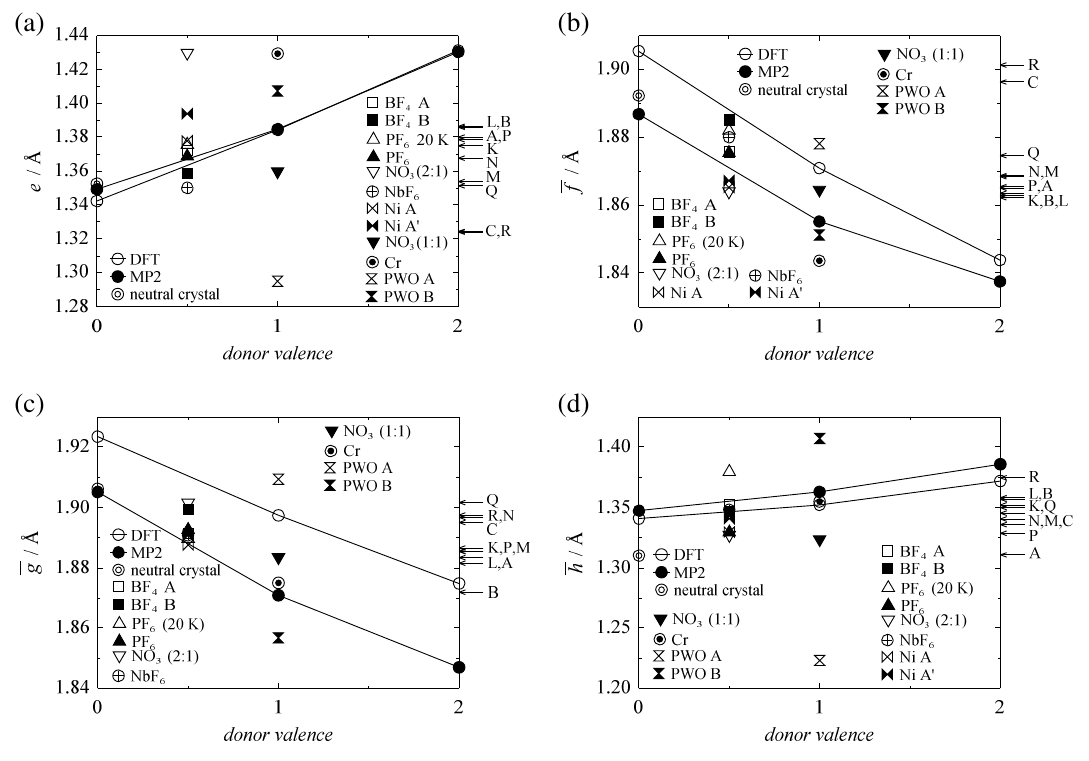
Figure 10. Dependence of the bond lengths ( a ) e , ( b ) f , ( c ) g , and ( d ) h of the TMTSF molecules in the crystals on the valence expected from their chemical compositions. The open and closed circles show the corresponding bond lengths in the optimized structures by the quantum mechanical calculations (see text and the caption in Table 2). The solid lines are guides to the